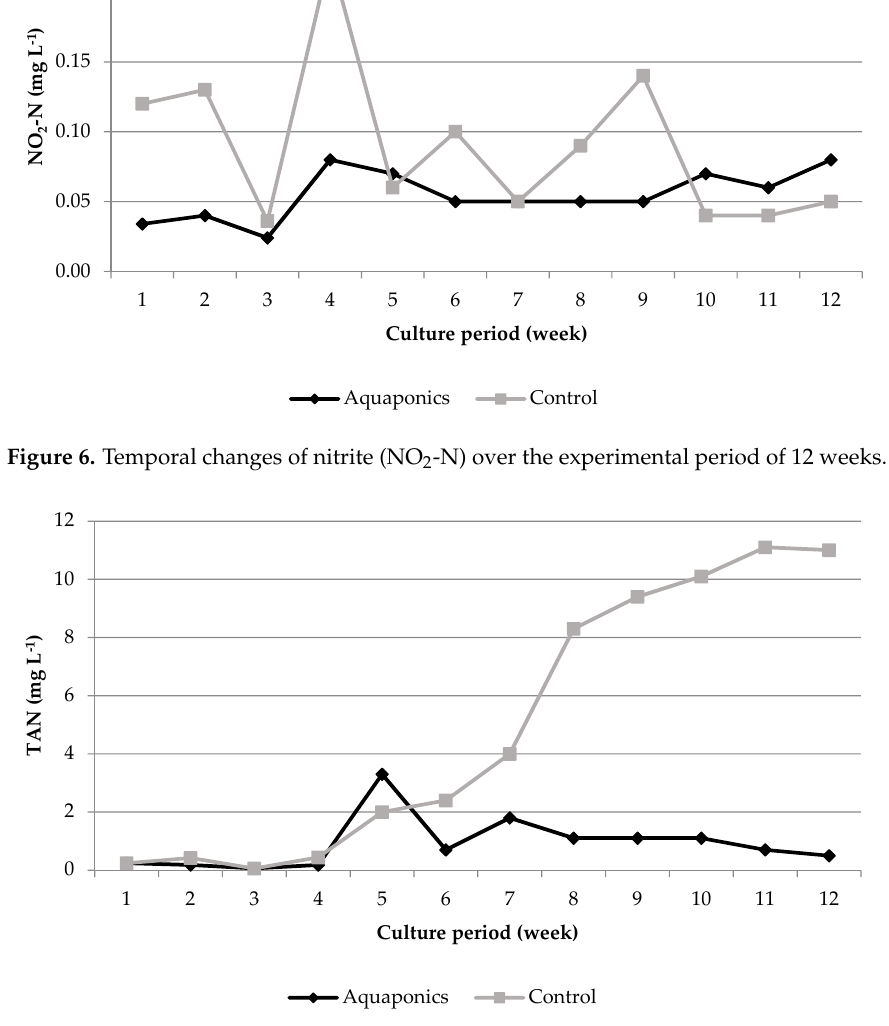
Figure 7. Temporal changes of total ammonium nitrogen over the experimental period of 12 weeks.